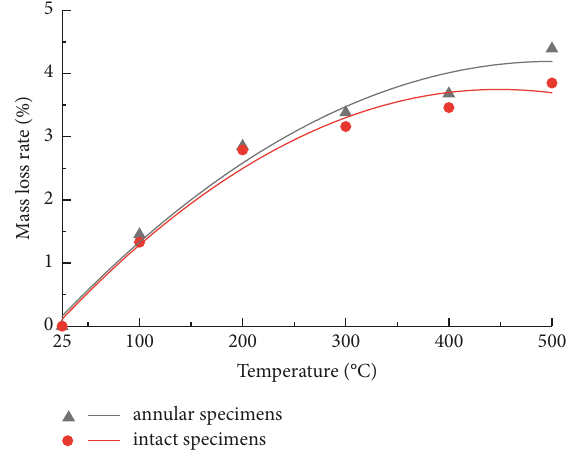
Figure 4: Variation in the mass of samples with heating temperature.